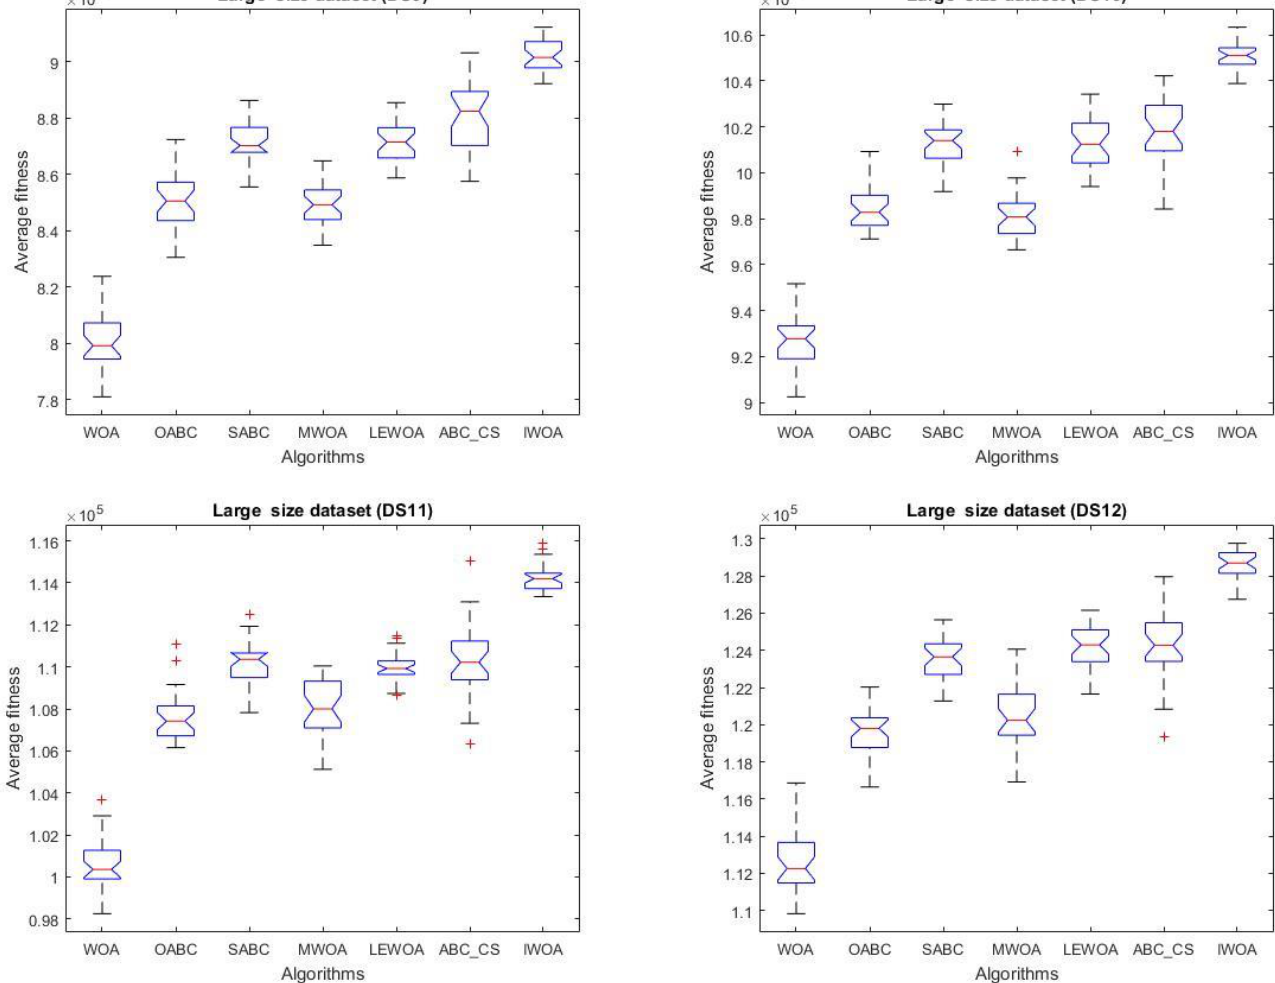
Figure 4. Boxplots for the average fitness value obtained using the compared algorithms for the large size dataset. Table 3. Best fitness values (BFV), standard deviation (STD), and average execution time (AET) val- ues for IWOA compared to other algorithms.